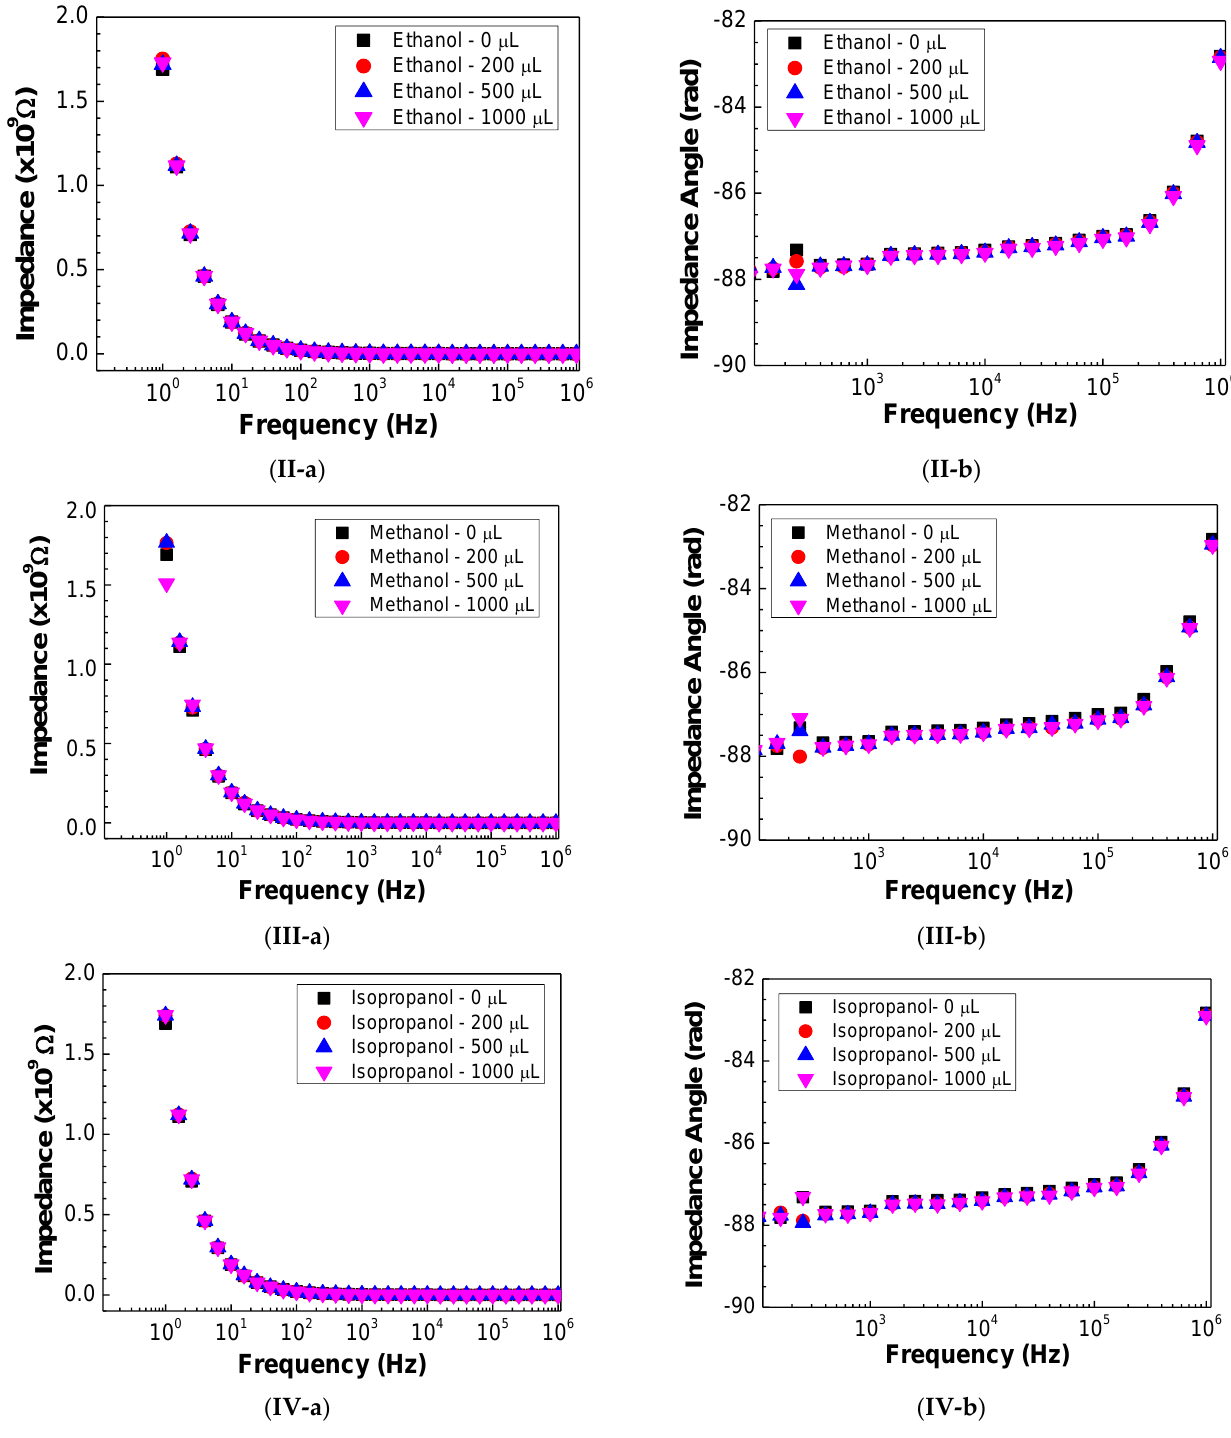
Figure 1. Impedance ( a ) and impedance angle ( b ) spectra of the sensor devices when exposed to atmospheres with different concentrations of acetic acid ( I ), ethanol ( II ), methanol ( III ), and isopropanol ( IV ).